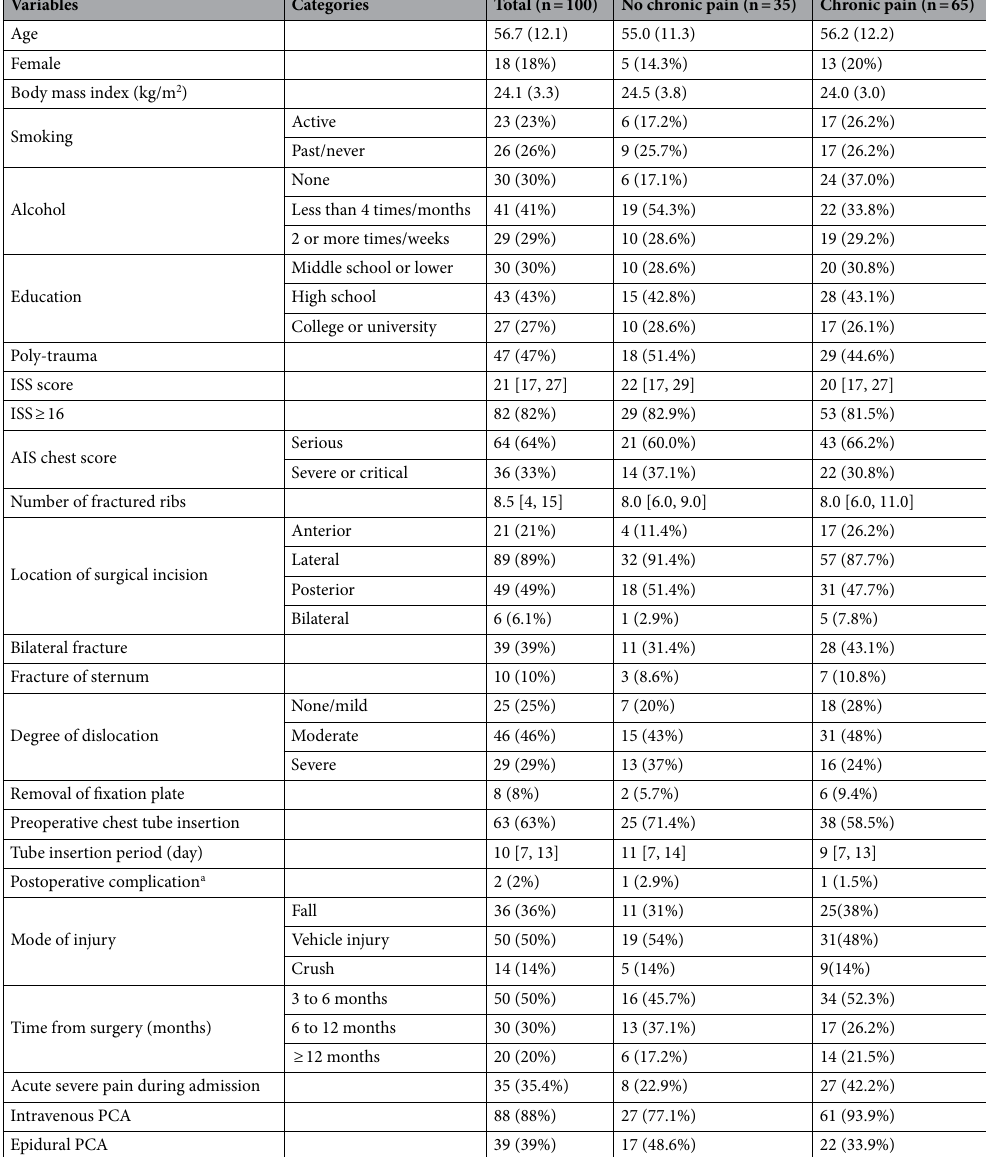
Table 1. Descriptive and bivariate analysis of demographic and clinical characteristics of the survey participants. AIS; abbreviated injury score, ISS; injury severity score, PCA; patient controlled analgesia. a Postoperative complications include superficial wound infections in both